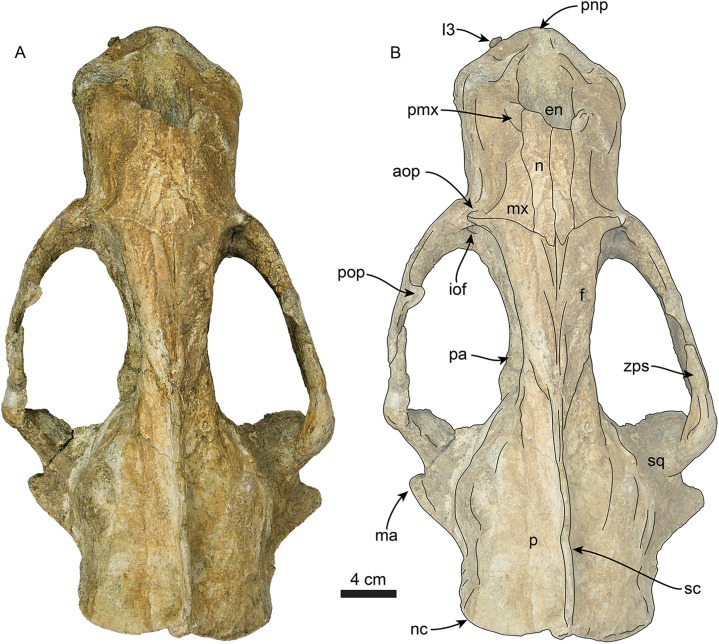
Skull of Titanotaria orangensis n. gen. et sp. (OCPC 11141).Skull in dorsal view, without labels (A) and labelled (B). Abbreviations: aop, antorbital process; en, external nares; f, frontal; I3, upper third incisor; iof, infraorbital foramen; ma, mastoid process; mx, maxilla; n, nasal; nc, nuchal crest; p, parietal; pa, palatine; pmx, premaxilla; pnp, prenarial process; pop, postorbital process; sc, sagittal crest; sq, squamosal; zps, zygomatic process of squamosal.